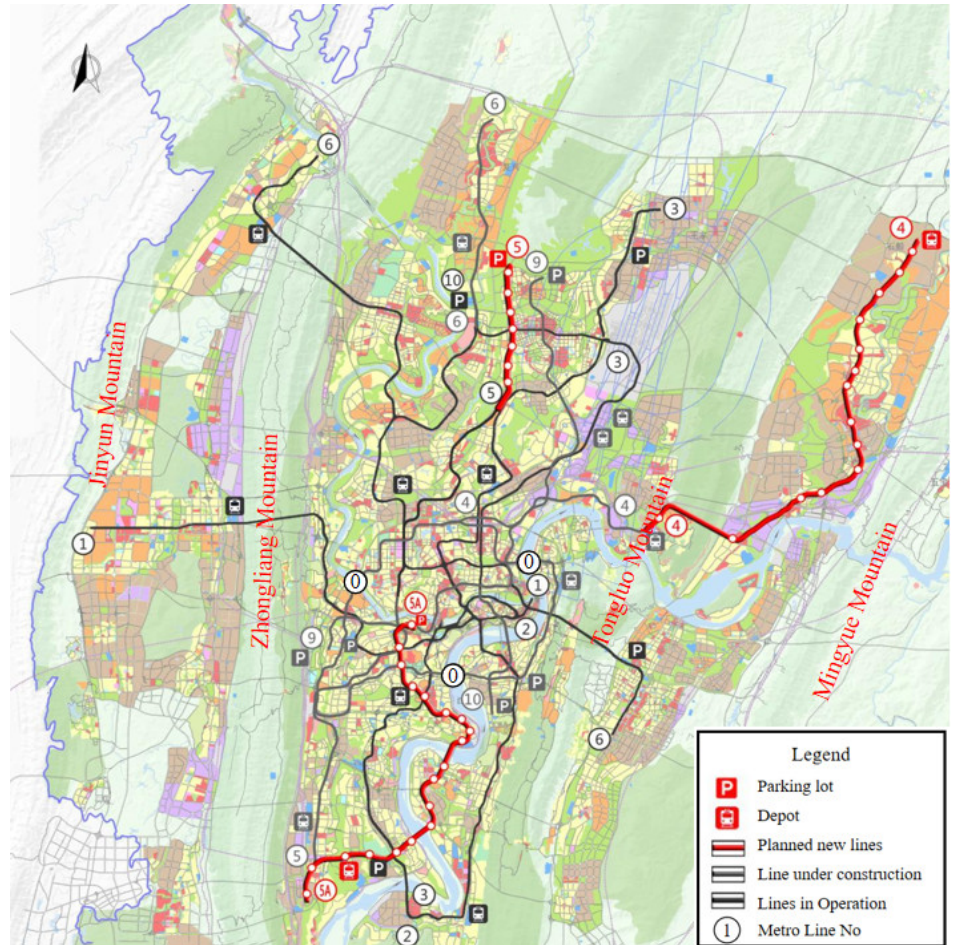
Figure 1. Schematic diagram of Chongqing urban rail transit phase III construction plan (2018–2023).